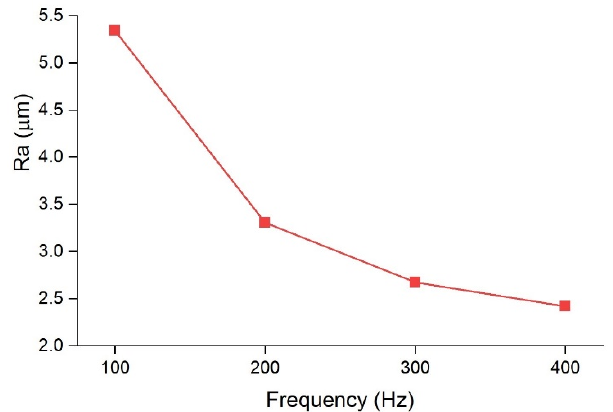
Hz, and 400 Hz oscillating frequencies. The oscillating amplitude was kept constant at 0.4 mm.